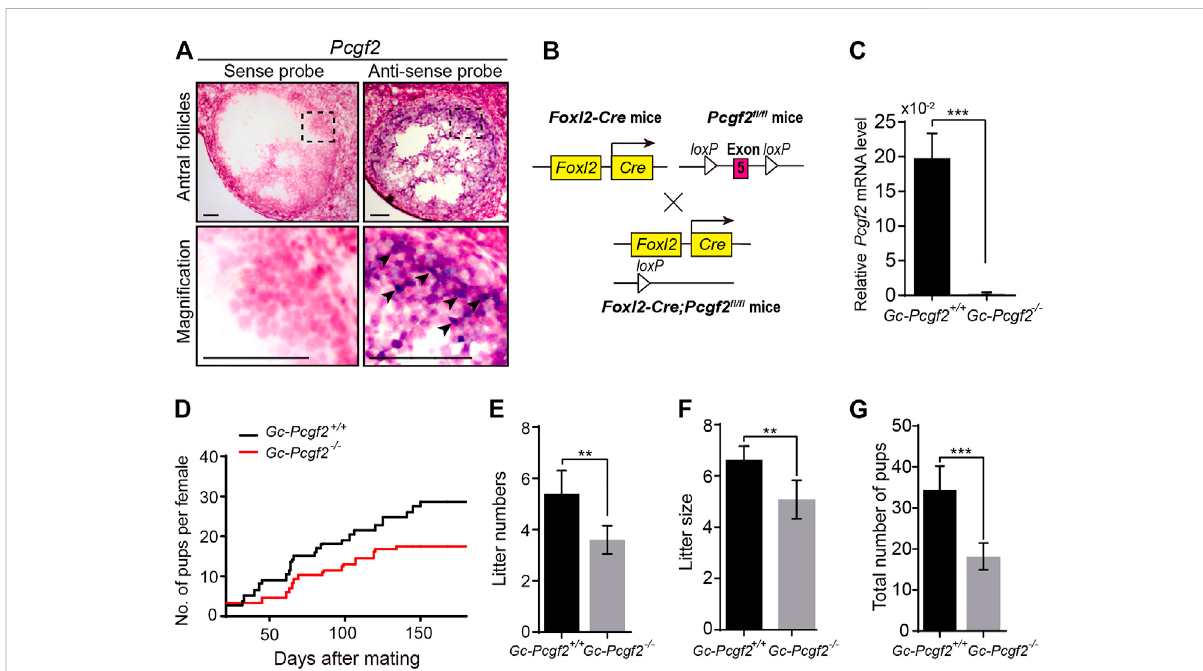
FIGURE 1 Deleting Pcgf2 fromovarianfolliclegranulosacellsdecreasesfertility. (A) Insitu hybridizationshowing Pcgf2 mainlyexpressedingranulosacells (arrowheads) of growing follicles ( n = 3 per group). Scale bars: 50 µm. (B) Schematic diagram of deletion of Pcgf2 exon 5 by Foxl2-Cre -mediated recombination in granulosa cells in GC-Pcgf2 − / − ovaries. (C) Quantitative real-time PCR (QRT-PCR) result showing the mRNA level of Pcgf2 sharply reducedingranulosacellsof GC-Pcgf2 − / − ovaries( n =3pergroup). (D – G) Fertilitycheckingshowingasubfertilityphenotypeinthe GC-Pcgf2 − / − female mice after mating with healthy wild-type males at 6 months. (D) Fertility checking result showing a subfertility phenotype in the GC-Pcgf2 − /